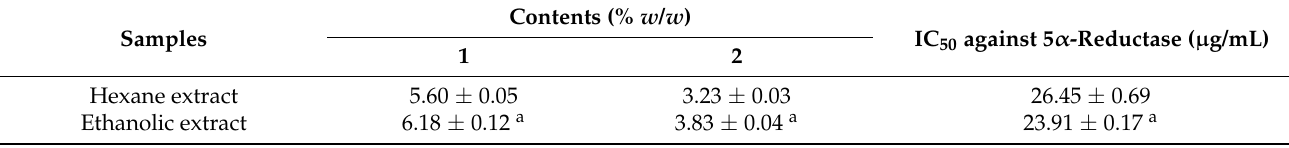
Table 4. The contents of two 5 α -reductase inhibitors ( 1 and 2 ) in hexane and ethanolic extracts of T. grandis leaf and IC 50 values against 5 α -reductase of T. grandis leaf extracts. The data are expressed as the means ± standard deviation (SD) of triplicate